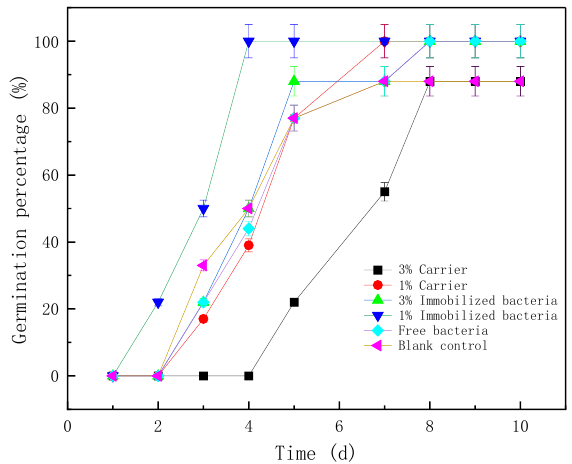
Figure 9. The effect of zeolite and bacteria on corn germination